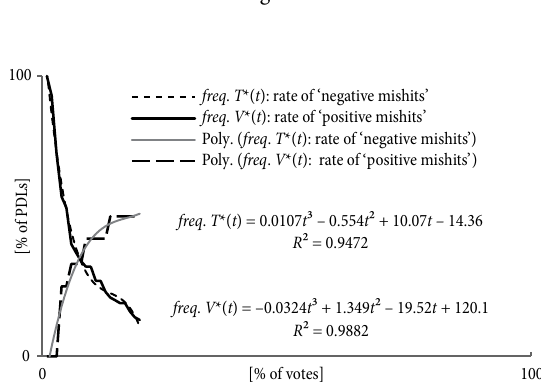
Fig. 3. Optimisation made using equalizing of frequencies of mishits